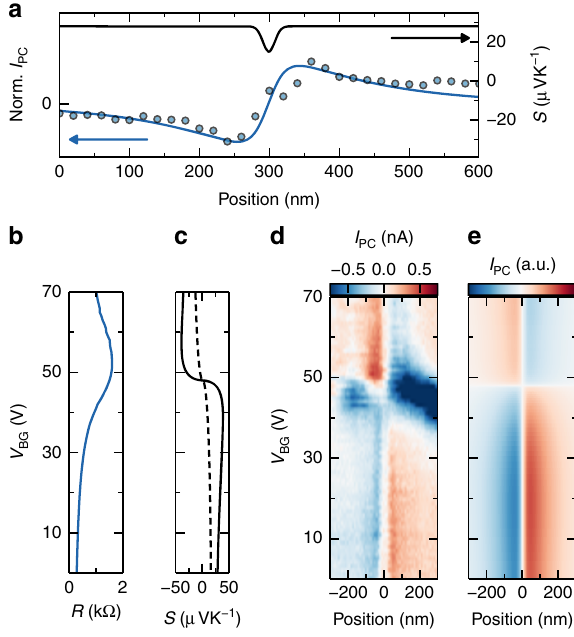
Figure 3 | Photocurrent from charge puddles. ( a ) Near-field photocurrent map of an exfoliated graphene device on 300nm SiO 2 at V BG ¼ 20V. The dashed lines indicate the position of the contacts and solid lines the graphene edges. The green box indicates the measurement region in b (scale bar, 5 m m). ( b ) Detailed photocurrent map at the charge neutrality point of the device ( V BG ¼ 7V) reveals the charge puddles and the high spatial resolution of the technique. (scale bar, 1 m m) ( c ) Autocorrelation of the photocurrent from charge puddles at V D (data points) compared to photocurrent expected from a random charge puddle distribution and l cool ¼ 200nm (blue curve). Autocorrelation is taken along the source drain current path.